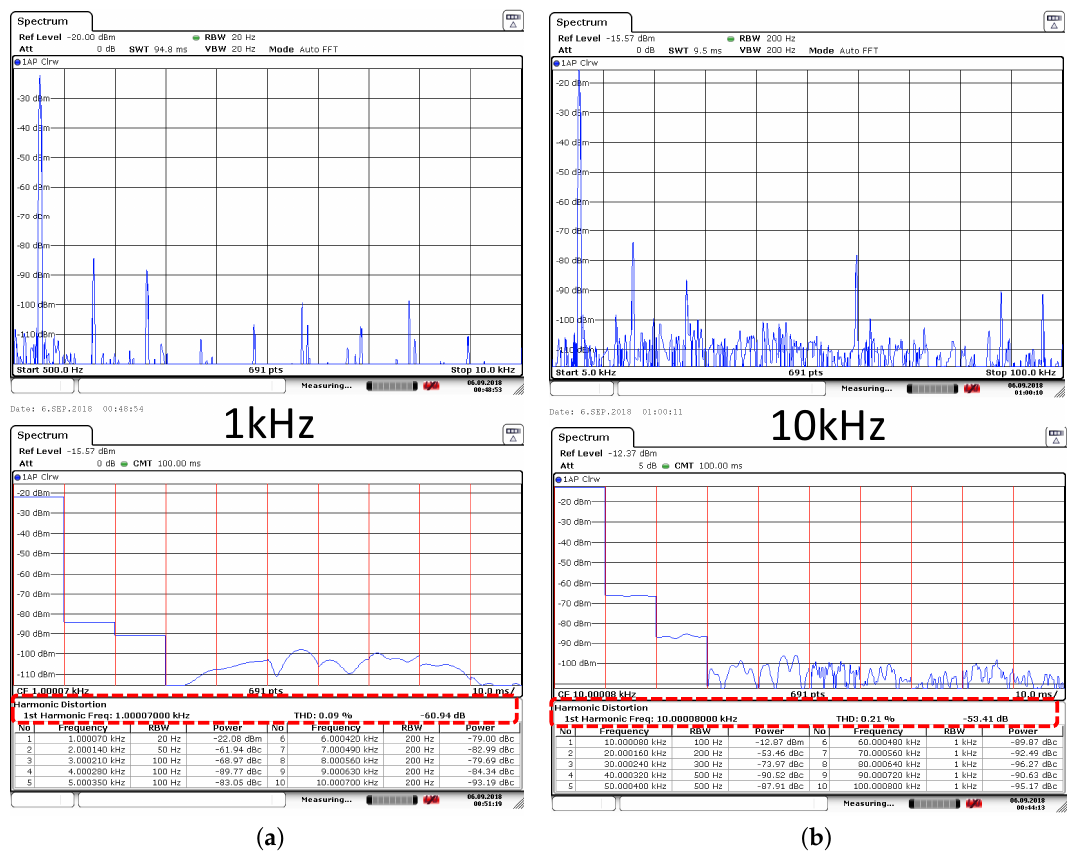
Figure 16. Integrated current buffer THD characterization for a 60 µ A pp input current at: ( a ) 1 kHz; and ( b ) 10 kHz considering ten harmonics.